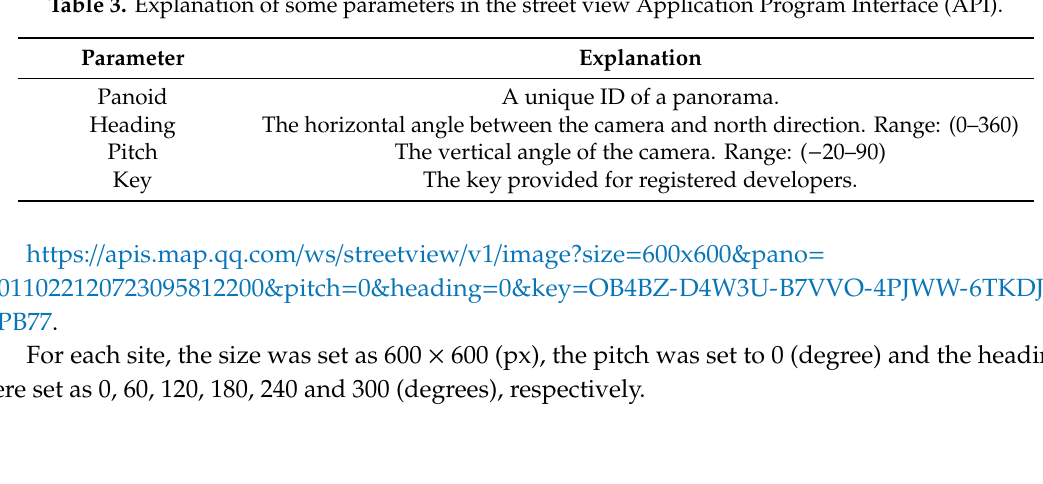
Table 3. Explanation of some parameters in the street view Application Program Interface (API).